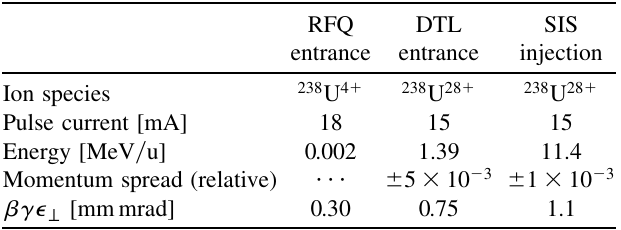
TABLE I. Design beam parameters of the UNILAC for ura- nium as required by FAIR. The term (cid:1)(cid:2)(cid:3) ? refers to the normalized, total transverse emittance.